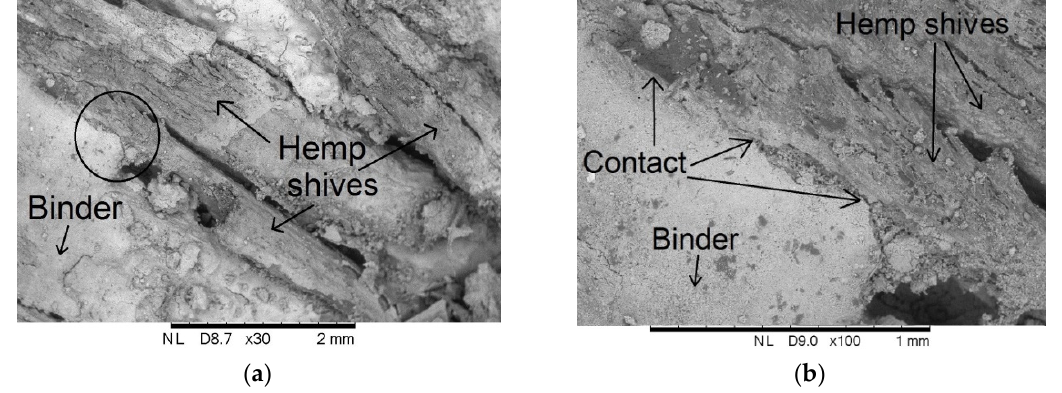
Figure 18. Scanning Electron Microscope (SEM) Image of contact between hemp shiv and binder of lime–hemp composite: ( a ) magnification 30×, and ( b ) magnification 100×.